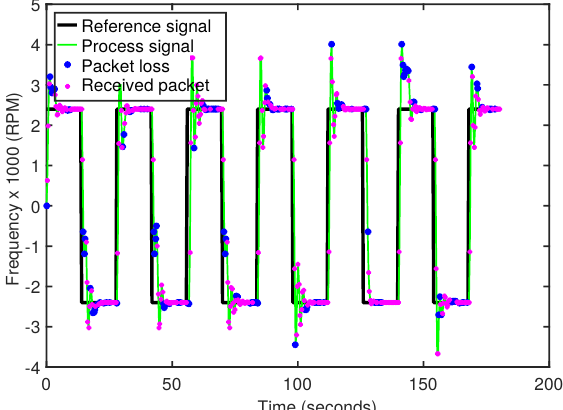
Figure 14. Functioning of the recovered process after the analysis of the lost